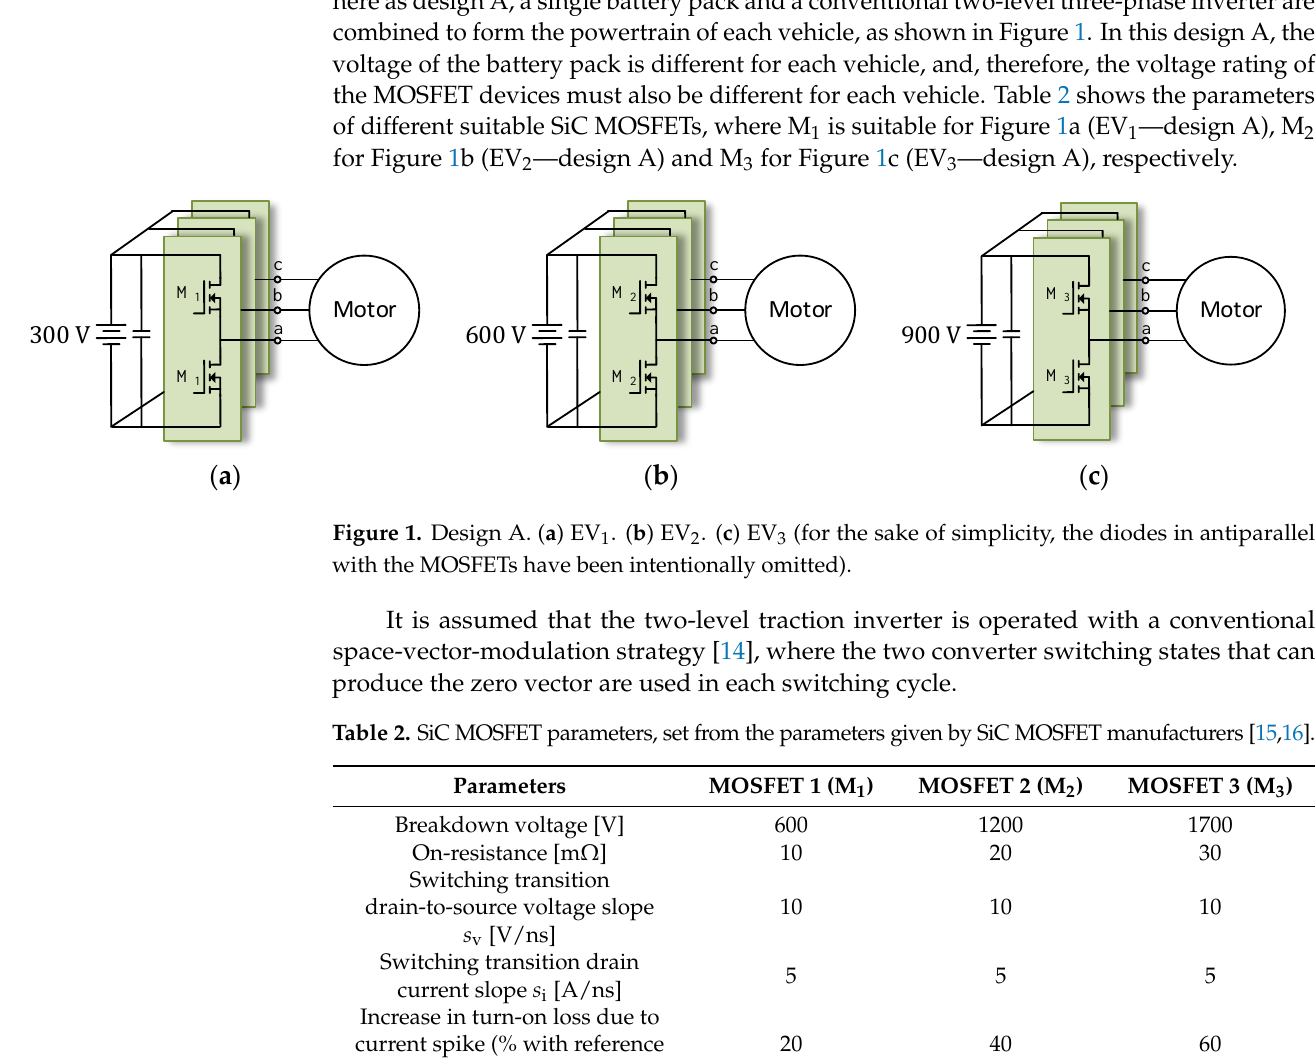
Table 2. SiC MOSFET parameters, set from the parameters given by SiC MOSFET manufacturers [15,16].